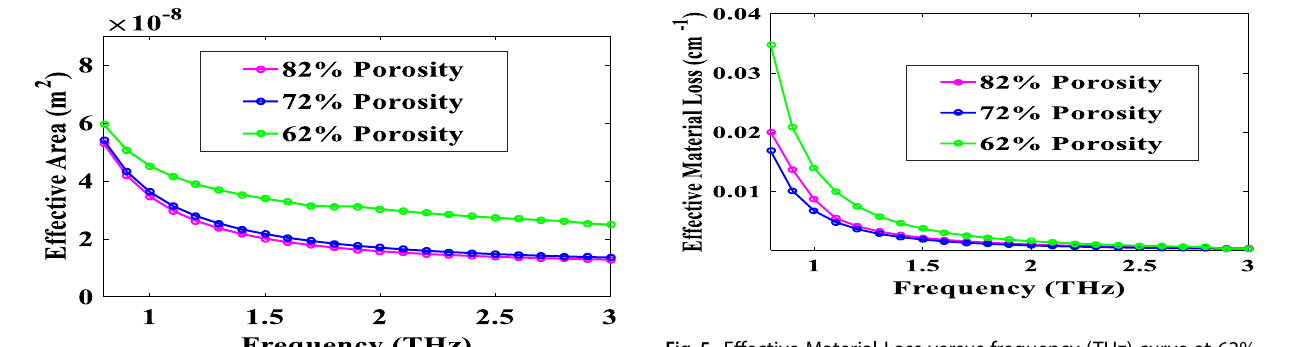
Fig. 5 Effective Material Loss versus frequency (THz) curve at 62%, 72% and 82% porosity